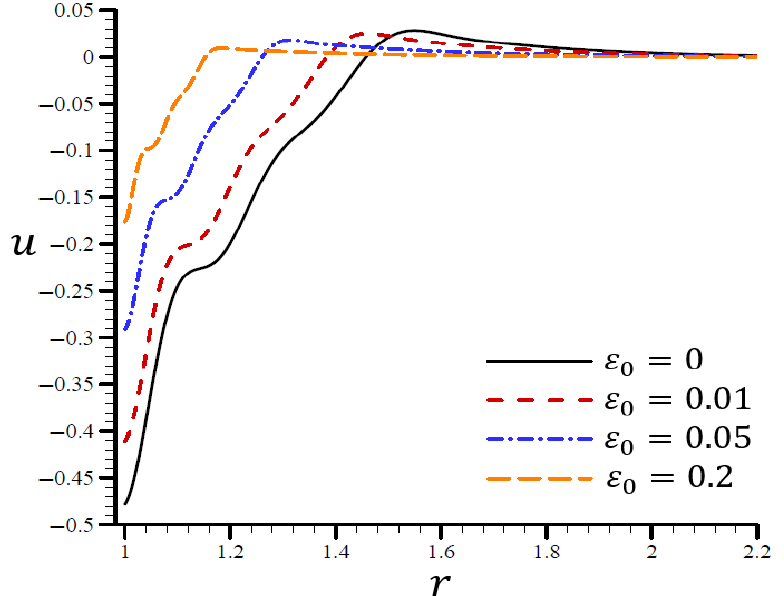
Figure 19. The influence of ε 0 on radial displacement u through the radial direction of the spherical hole using the RTPL model.